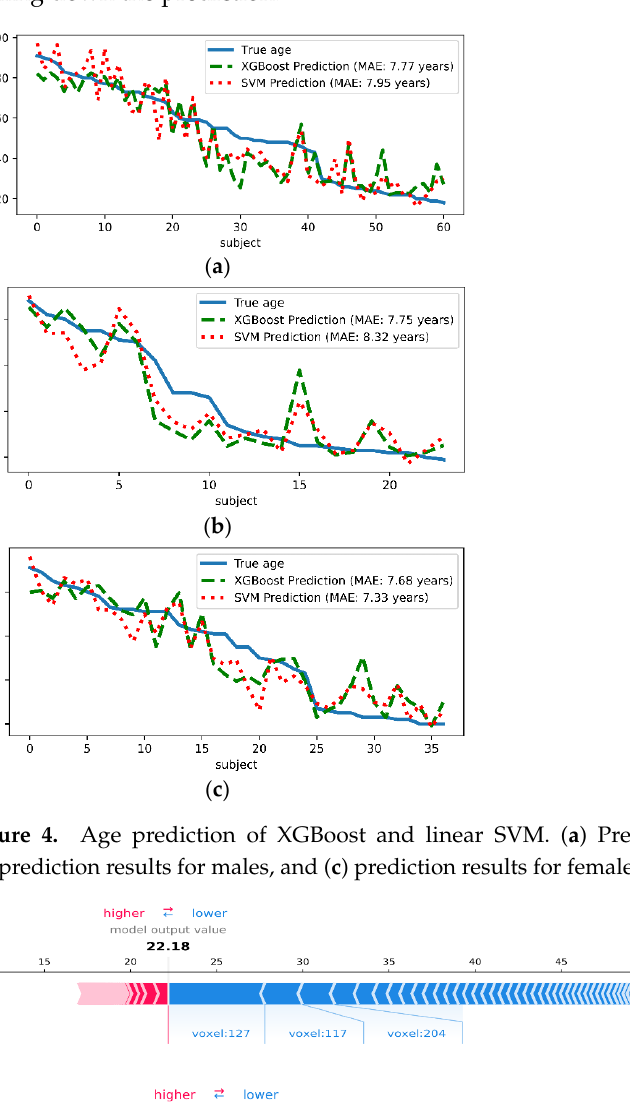
Figure 5. Force-plot of three subjects. The arrows represent the SHAP values corresponding to the voxels. Red and blue mark the positive and negative SHAP values, representing the positive and negative contributions of each voxel to the model output, respectively, while the length of the arrows represents the degree of the contribution. The horizontal coordinates are labeled age, the model output is the age prediction, and the number to the right of each arrow bar is the true age.